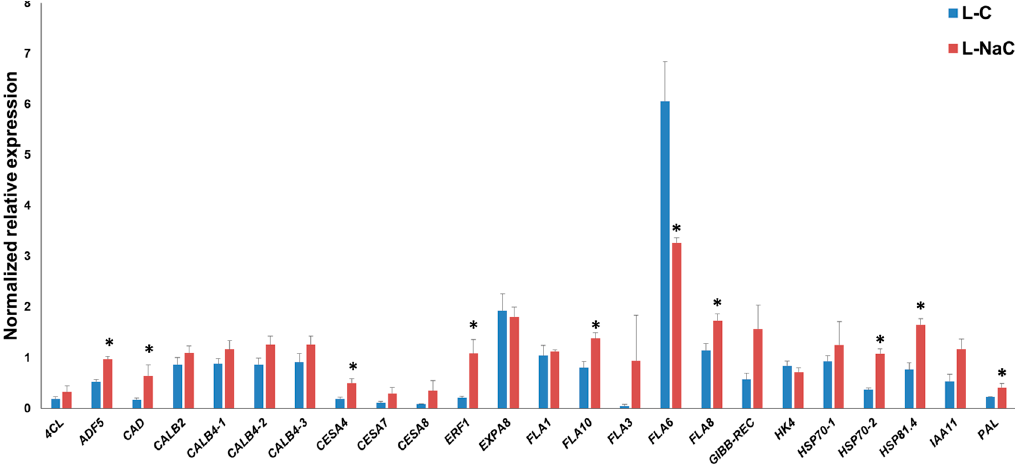
Figure 2. Reverse Transcription-quantitative PCR (RT-qPCR) of hemp leaves under control (L-C) and NaCl exposure (L-NaCl). The asterisks (*) indicates statistically significant differences calculated with the Student’s t -test ( p < 0.05).